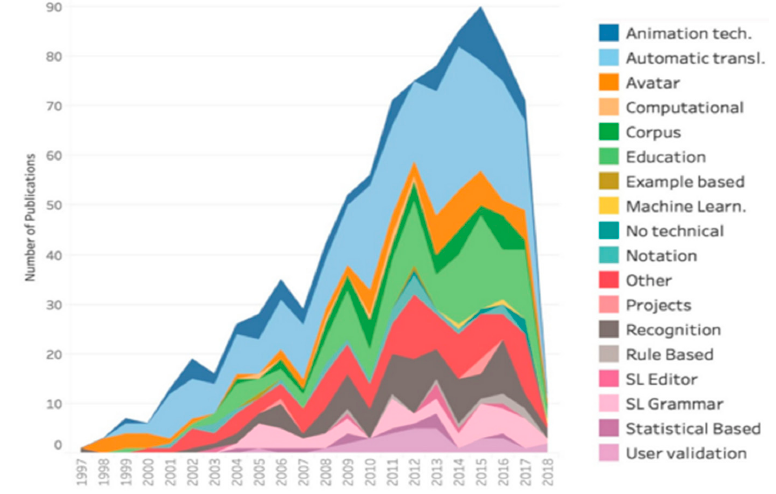
Figure 3. Classification-Years area chart.